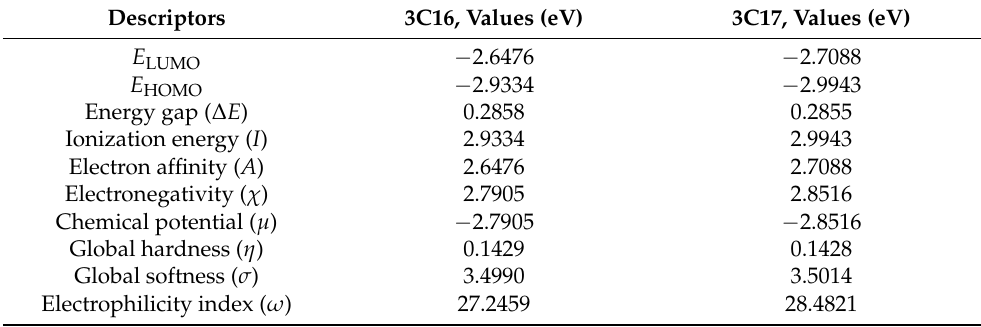
Table 8. Calculation results of reactivity descriptors [51] of 3C16 and 3C17